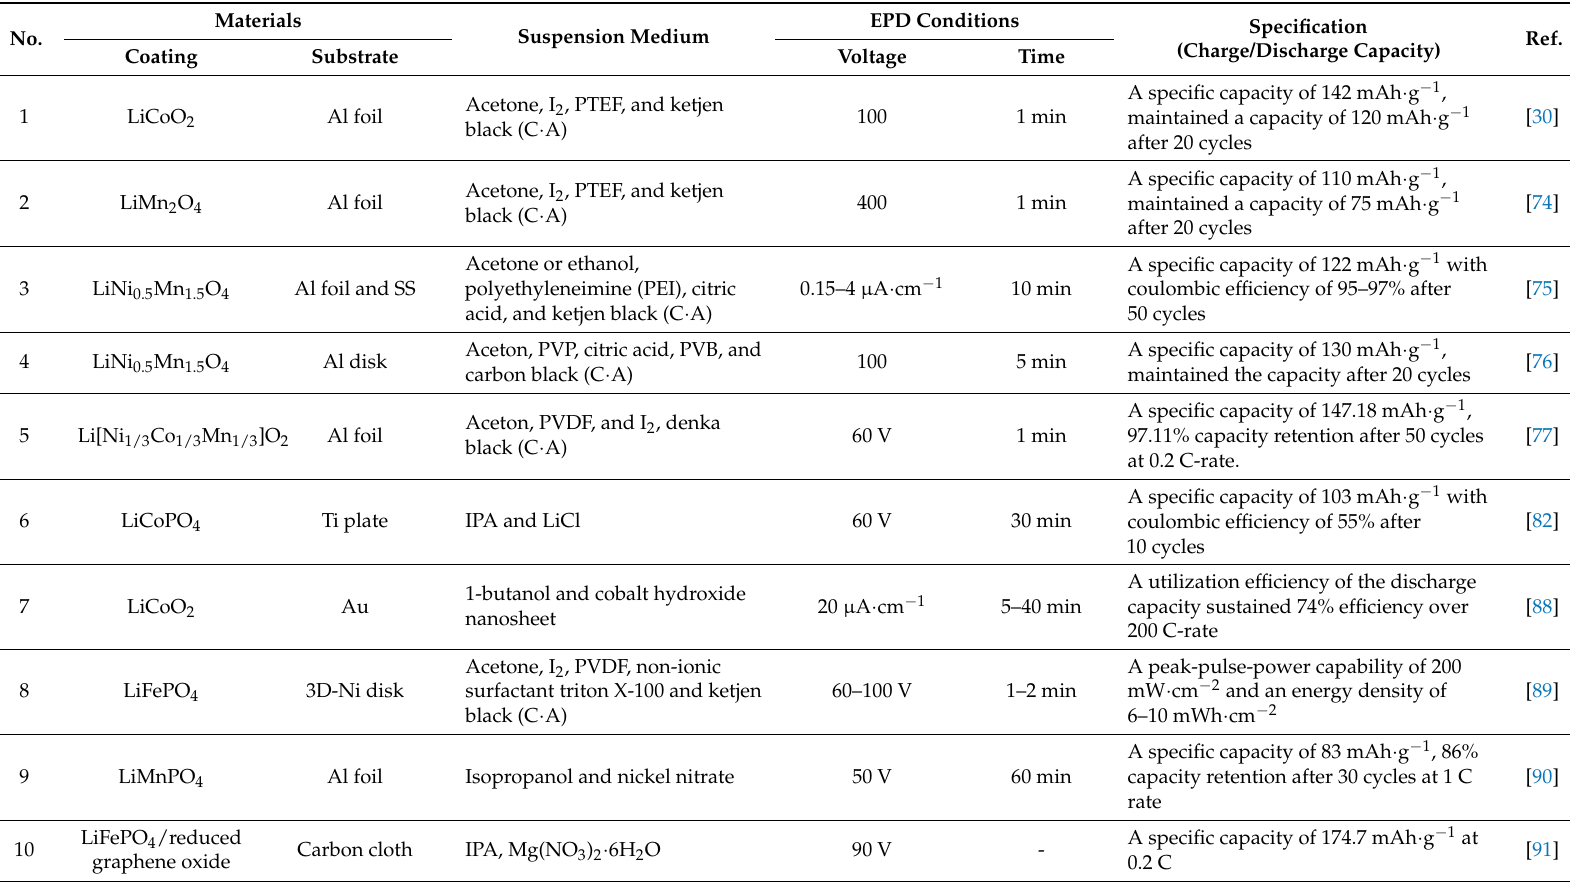
Table A1. Overview of cathode electrodes designed by EPD showing the nanomaterials for Li-ion batteries and EPD conditions